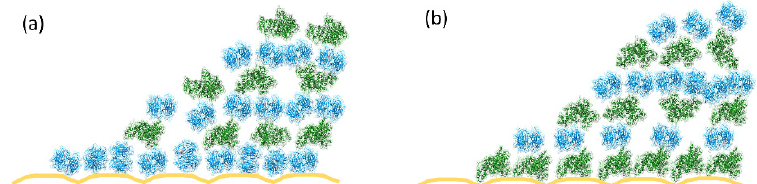
Figure 4. Schematic representation of the surface architecture achieved in the adsorption experiments. ( a ) Shows the adsorption sequence starting with Nav, and ( b )—starting with bBSA. The gold is shown in yellow, Nav in light blue, and BSA in green. No distinction is made between the biotinylated and non-biotinylated BSA. The vertical dimension of the roughness of the gold is to scale with the sizes of the proteins; similarly, the protein dimensions are also drawn to scale relative to each other, but Nav aggregation is ignored for simplicity. On average, there is ~ one bBSA molecule for every two Nav molecules adsorbed on gold. Away from the surface, there are ~ three Nav molecules per every bBSA molecule. See Section S2 in the Supporting Information for further discussion. This figure was prepared using USCF Chimera version 1.14 [35].